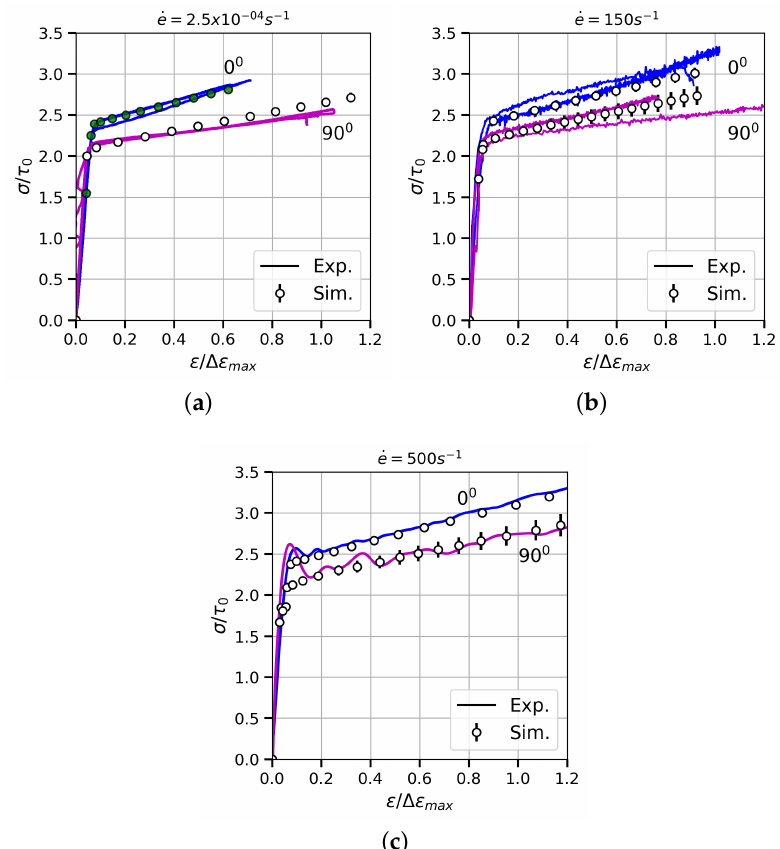
Figure 8. Experimental (lines) and numerical (markers) true stress–strain curves for MAR-M247DS alloy at room temperature under quasi-static ( a ) and dynamic ( b , c ) regimes and different loading directions. The green markers in the plot ( a ) are related to the fitting of the hardening